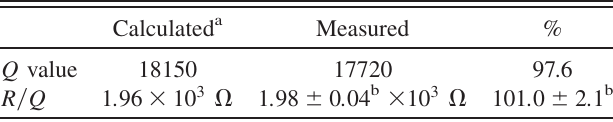
measurement us- 21